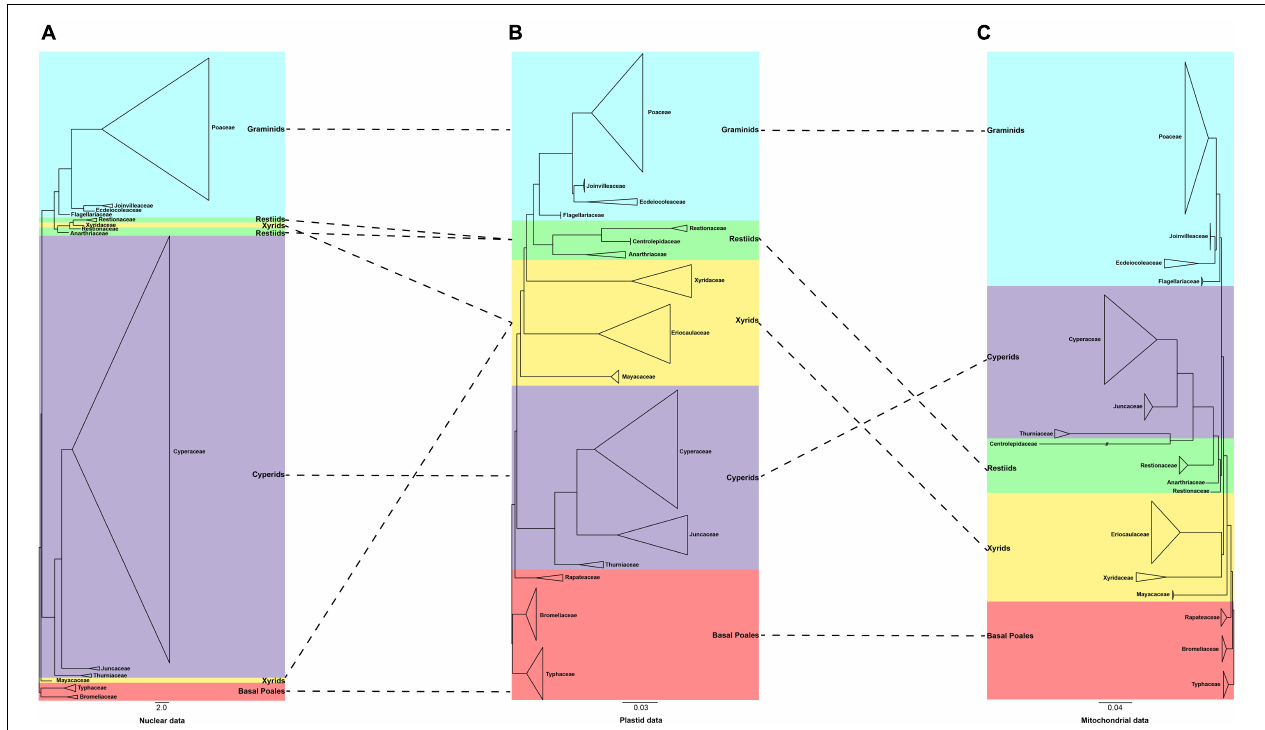
FIGURE 4 | A comparison of the phylogenies obtained from the plastid, mitochondrial, and nuclear matrices. (A) 353 nuclear data set [adopted from Baker et al. (2021)] (B) 80 plastid data set (C) 28 mitochondrial data set. The clades are shown in different colors in Figure 1 . The branch with “//” was shortened by